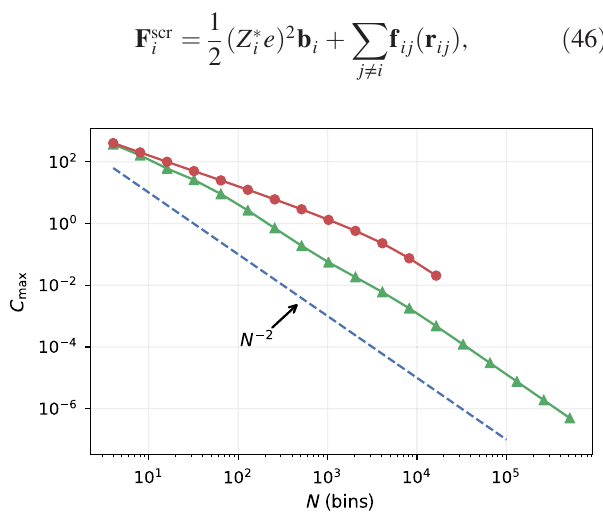
FIG. 4. Maximal correction. Maximum magnitude of the first- order correction in Eq. (43) evaluated across a bin given by the expression (45) as a function of number of bins. The two cases shown are for an initial sharp interface at t ¼ 0 ps (red curve, circles) and a later diffuse interface at t ¼ 15 ps (green curve, triangles). The curve N − 2 is also plotted to show the rough scaling of the